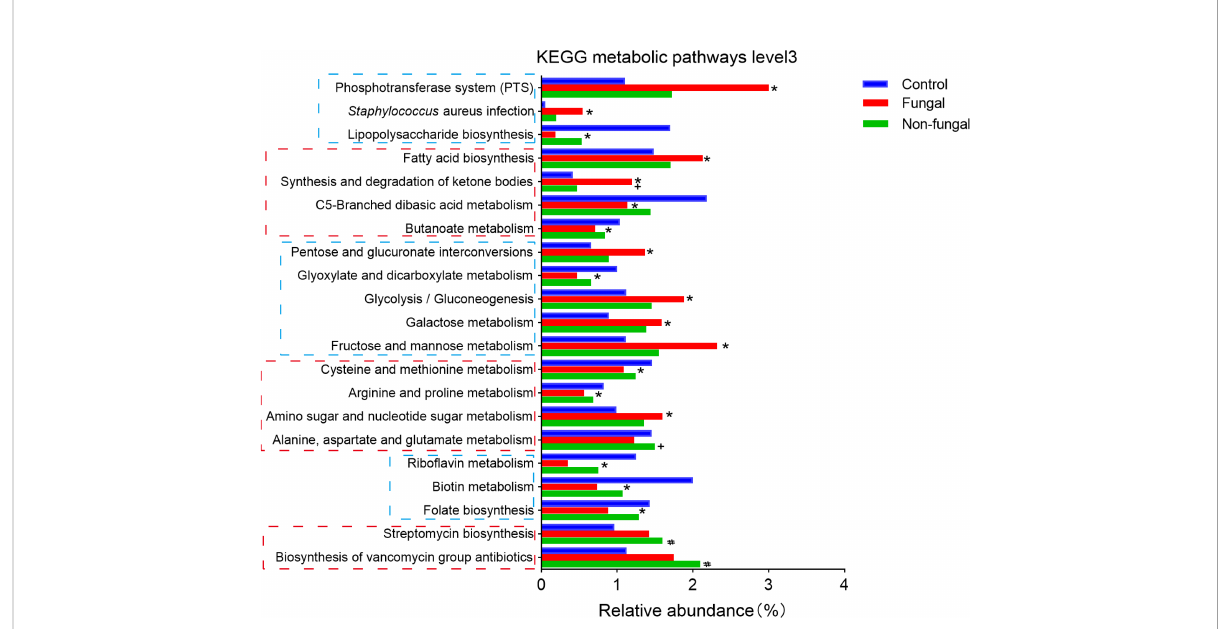
FIGURE 3 Differences of neonates in intestinal KEGG metabolic pathways level 3. *P < 0.05 vs Control, #P < 0.05 vs Control, +P < 0.05 vs Fungal. The P value was calculated with the Kruskal – Wallis